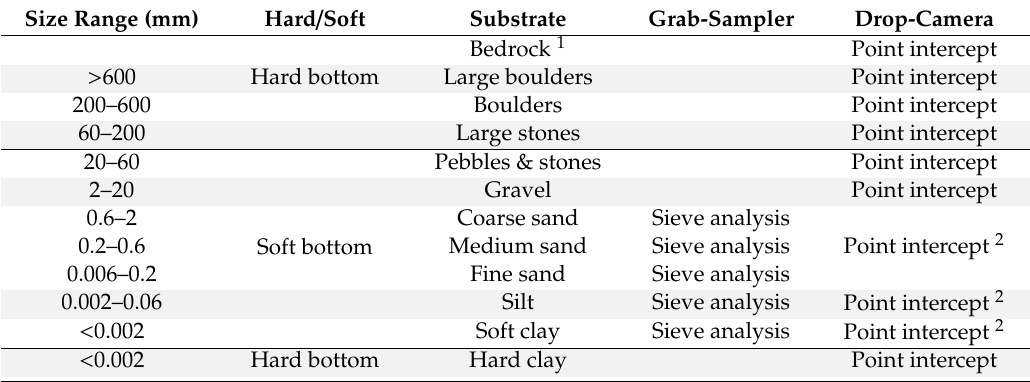
Table 2. Grain size ranges for the surface substrate compositions, and their sampling